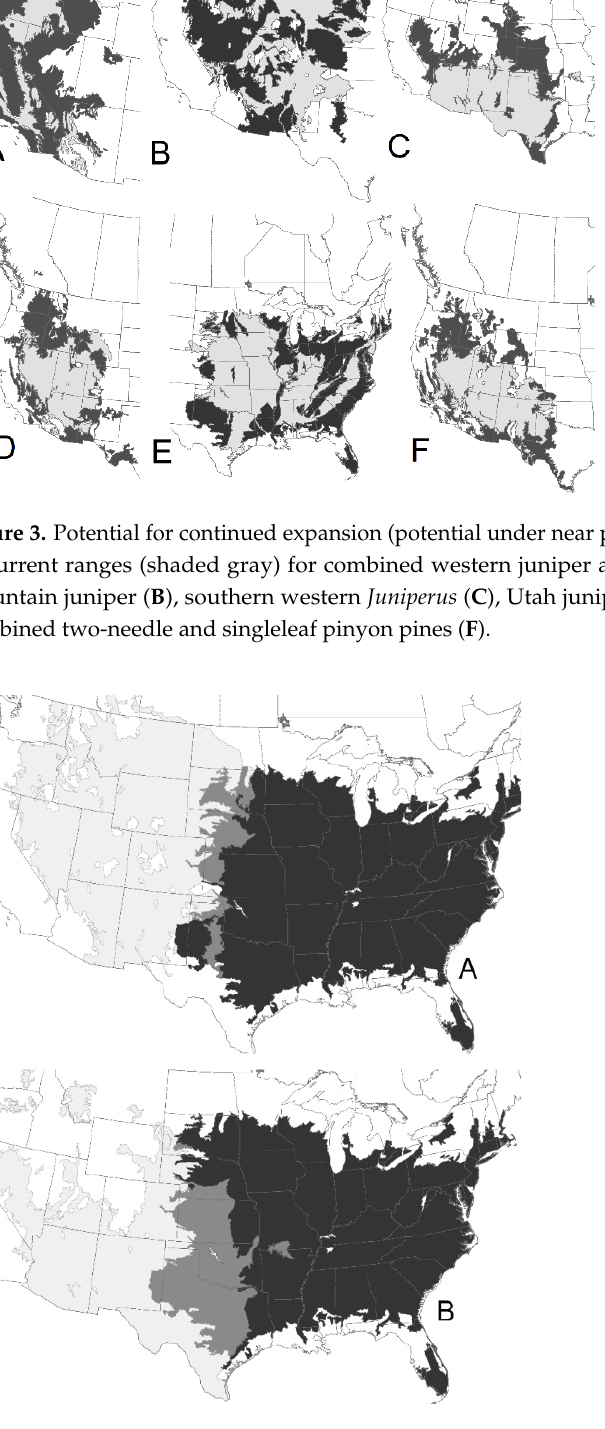
Figure 4. Potential for intersection (shaded dark gray) according to climate envelopes for Rocky Mountain juniper (light gray) and eastern redcedar (shaded black; ( A )) and the southern western Juniperus species (light gray) and eastern redcedar (shaded black; ( B )).